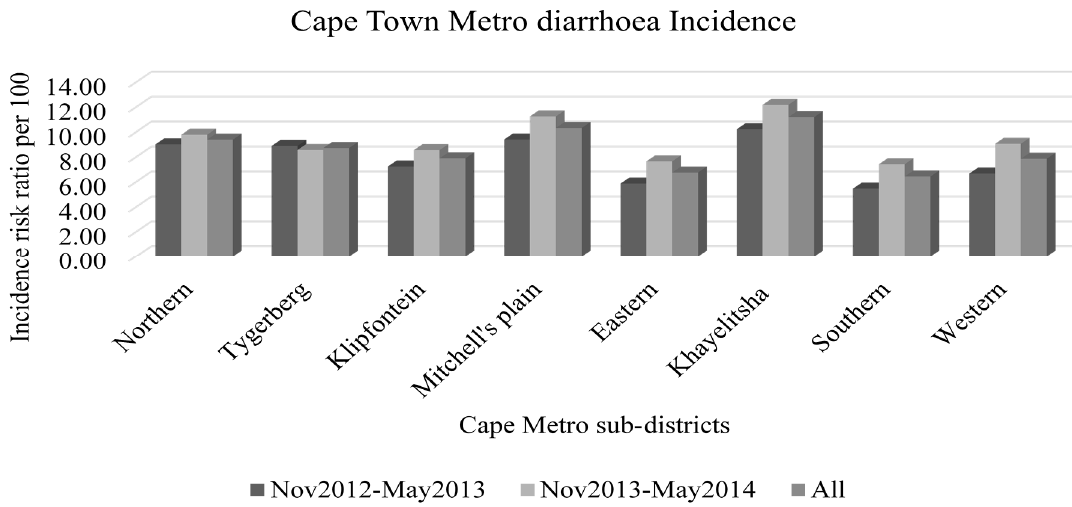
Figure 2. Distribution of diarrhoea incidence (number of cases/population at risk times 100) in different Cape-Metro sub-districts over the two selected periods and combined.